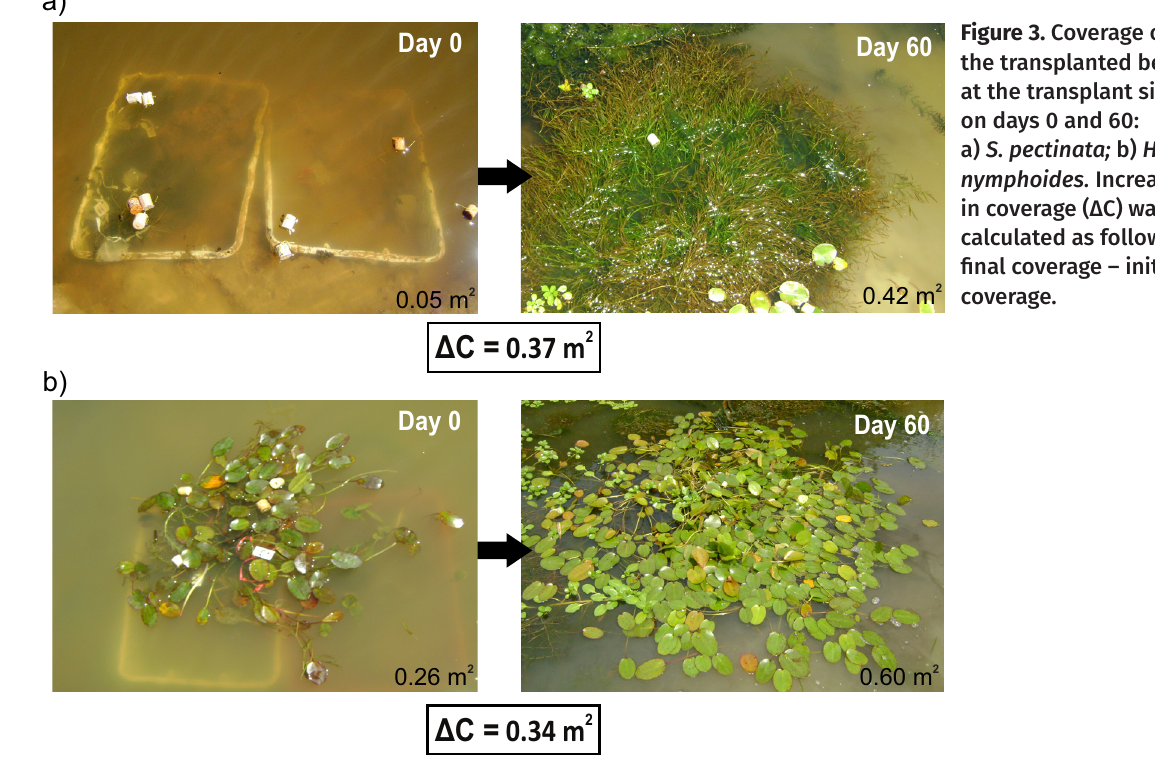
Figure 3. Coverage